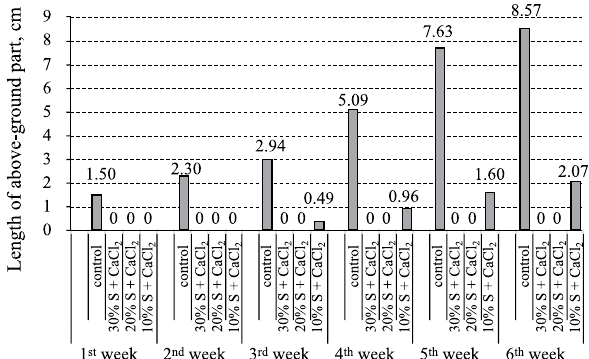
Fig. 15. Length variation of above-ground part of crimson clover in soil, contaminated with